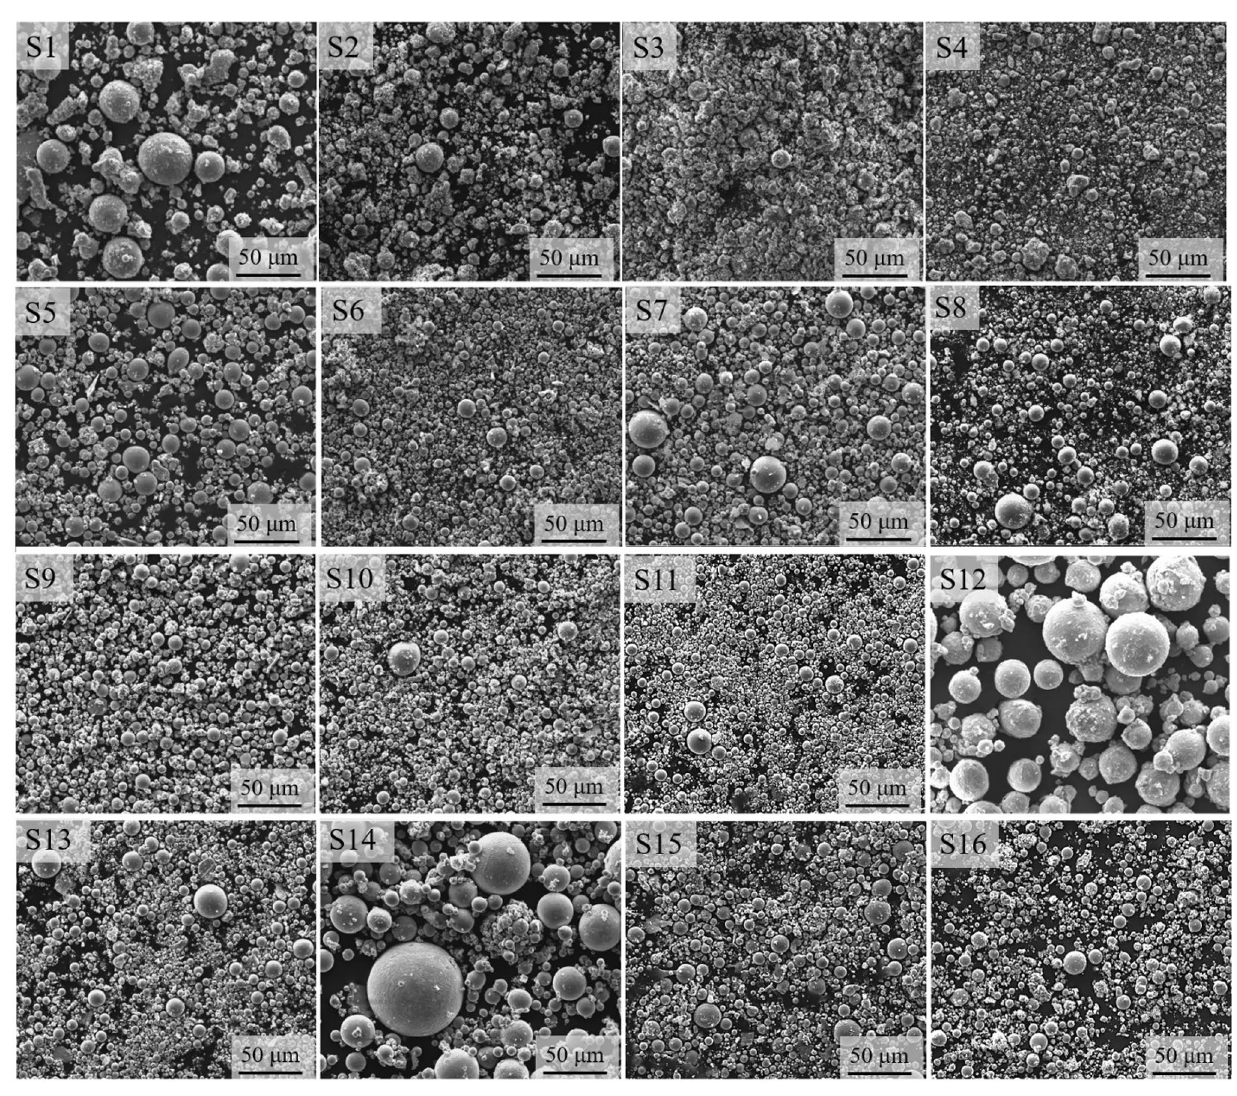
Fig. 5 SEM micrographs of the base Taguchi experiment powders